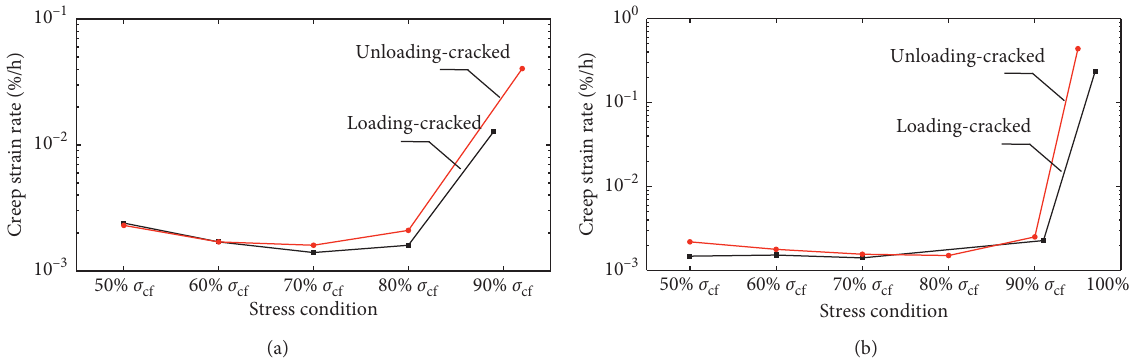
Figure 6: Creep strain rate in lateral direction. (a) σ